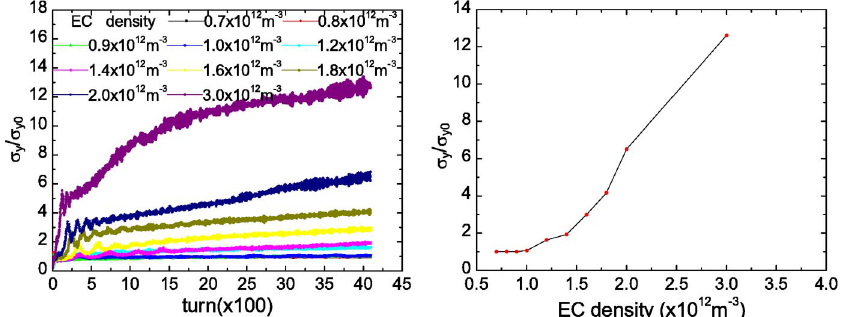
chromaticity.FIG. 16. (Color) Bunch size versus different EC